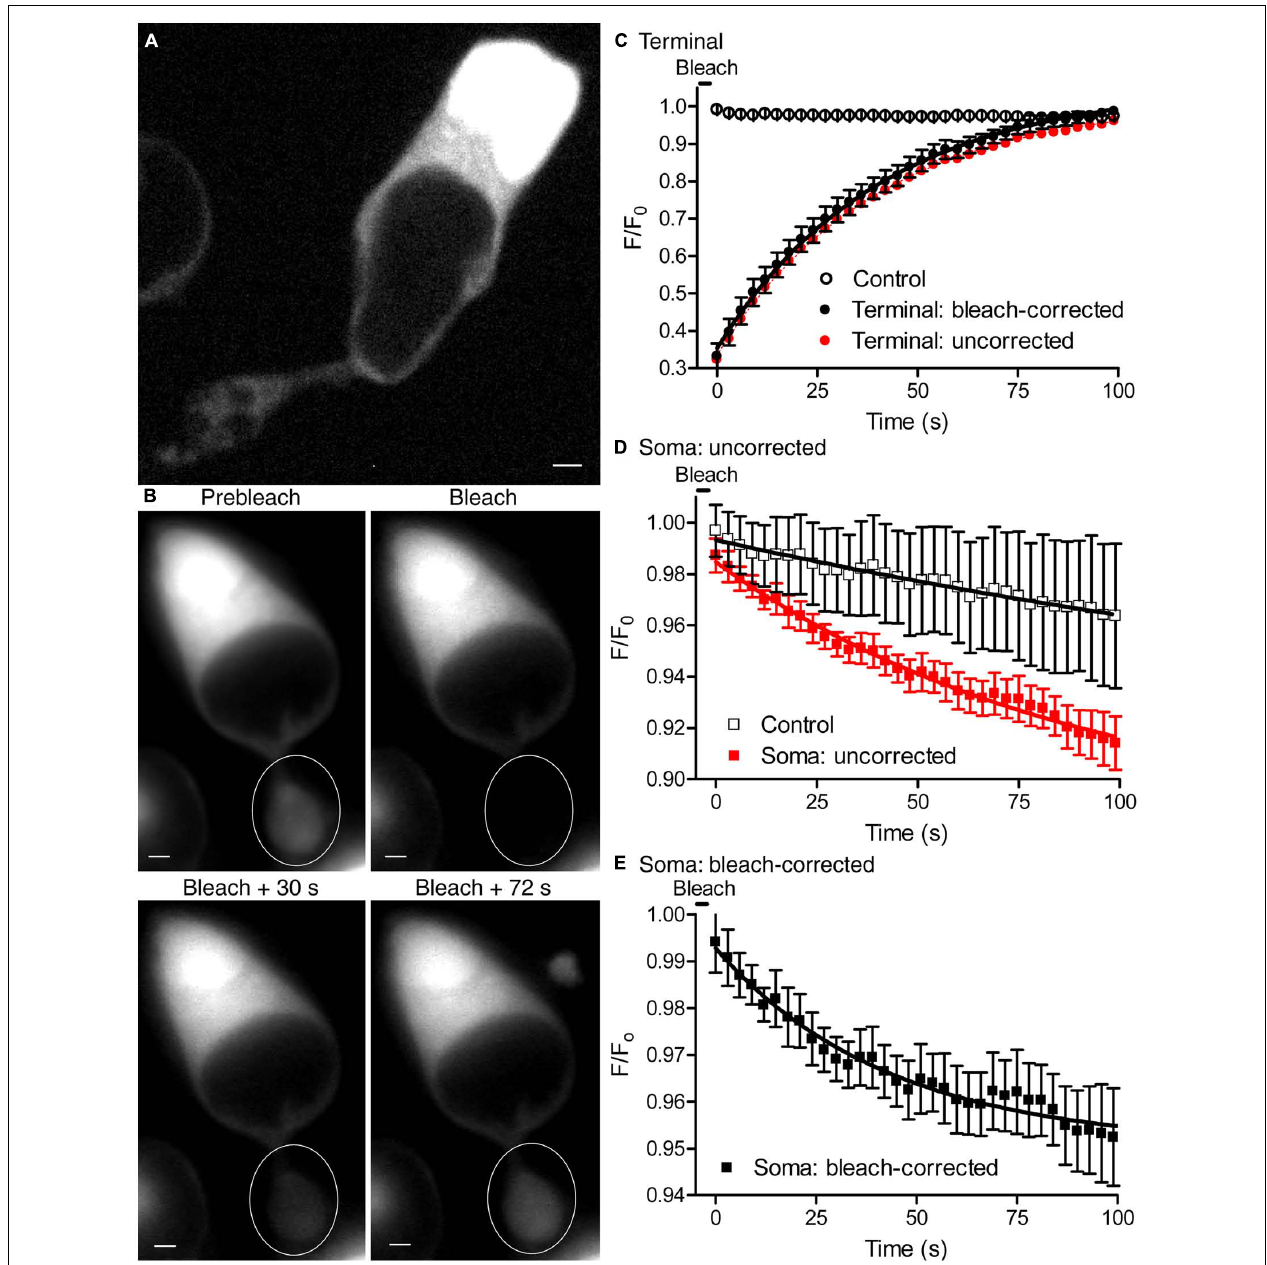
FIGURE 8 | Endoplasmic reticulum is continuous from soma to terminal. (A) A single confocal plane of an isolated rod labeled with ER-tracker green (1 μ M) and imaged with a spinning disk confocal microscope. Labeled intracellular structures are consistent with the presence of ER throughout the soma and terminal. (B) Series of images from an isolated rod loaded with ER-tracker green, showing fluorescence before and after laser photobleaching of the synaptic terminal (white circle). Scale bar: 2 μ m. (C) The time course of fluorescence ( F / F 0 ) changes in terminals after photobleaching with 488-nm laser spot of 8 μ m in diameter (filled red circles). F 0 is the average fluorescence intensity in the terminal before bleaching. Fluorescence changes in control terminals that were not laser photobleached are also plotted ( n = 5, open circles) to show bleaching caused by the epifluorescence illumination used to measure fluorescence recovery.The time course of fluorescence changes in terminals that were laser photobleached are also